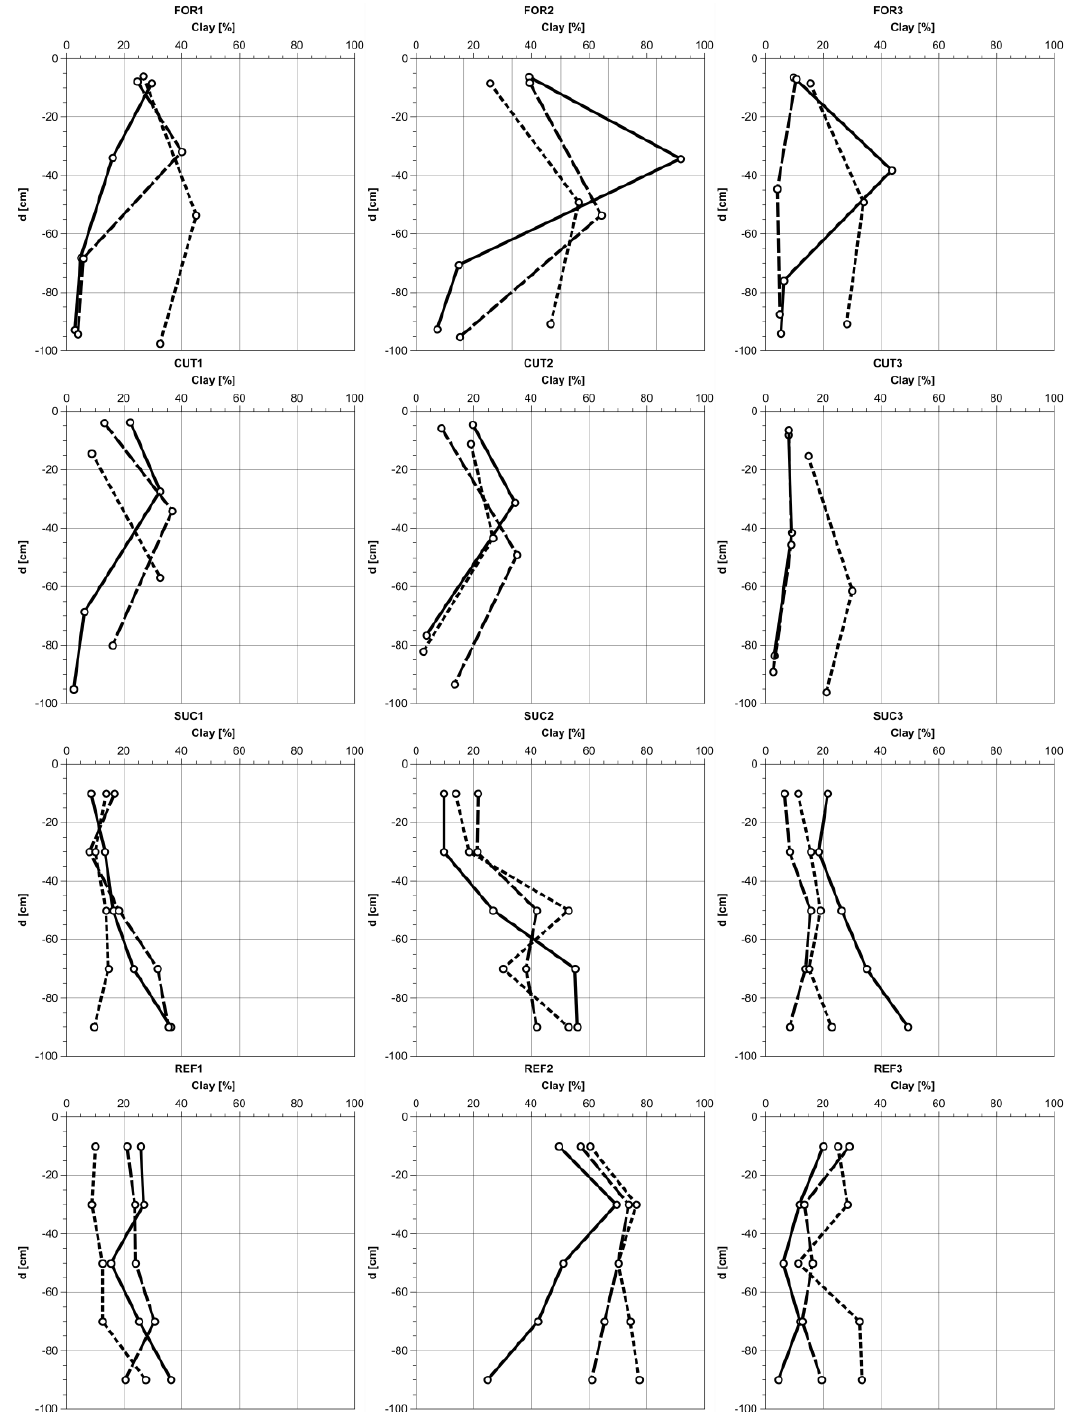
Figure 8. Depth-related clay content for every catena: (FOR)est, (CUT)-down, (SUC)cession, (REF)forested; solid line: upper slope, dashed line: middle slope, dotted line: lower slope.